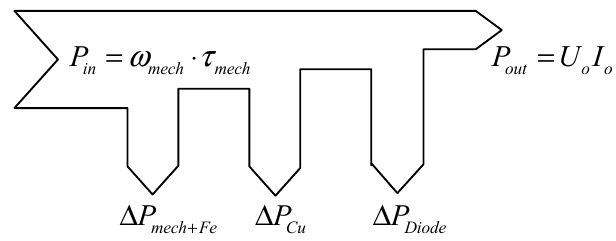
Figure 7. Energy flow diagram of the AFPM generator.